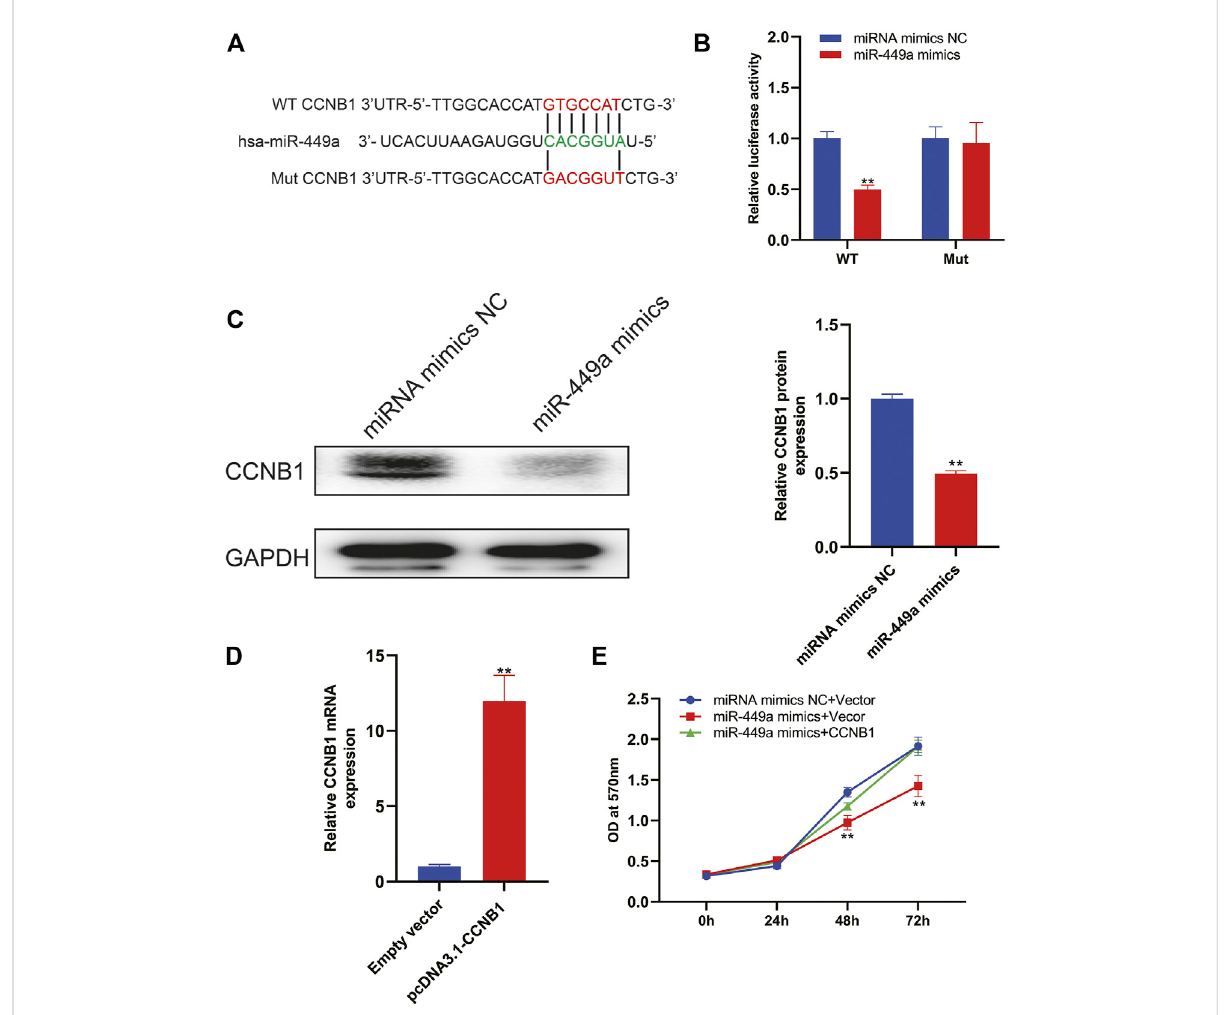
FIGURE 10 CCNB1 is downstream target of miR-449a. (A) MiR-449a binding sites and mutation sites. (B) MiR-449a mimics or miRNC and luciferase reporter vectors containing WT or mutant 3 ′ UTRs were co-transfected in SaOS-2 cells. (C) Western blot analysis was performed after miR-449a mimics and miR-NCweretransfected into cells. (D) Transfected SaOS2 cells with CCNB1 overexpression plasmid (pcDNA3.1-CCNB1) and RT-qPCR was performed to detect CCNB1 expression. (E) Following transfection, cell proliferation was analyzed by MTT